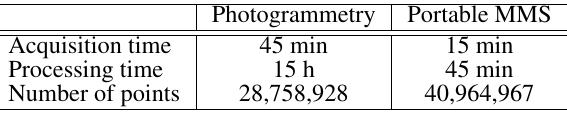
Table 1. Main characteristics of the photogrammetric and handheld MMS surveys. The number of points has been evaluated after clipping the 3D point clouds on the same area of